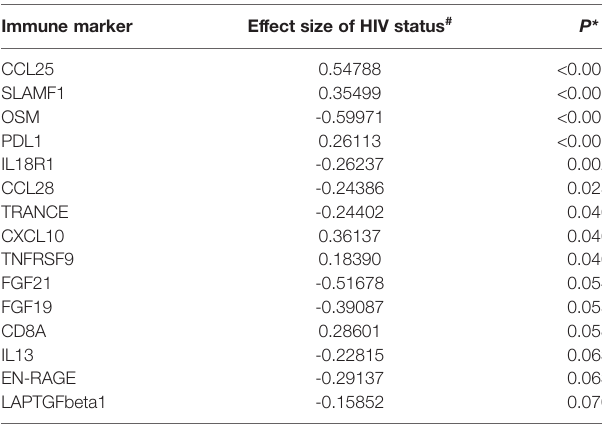
TABLE 2 | Immune markers in relation to HIV status. Immune